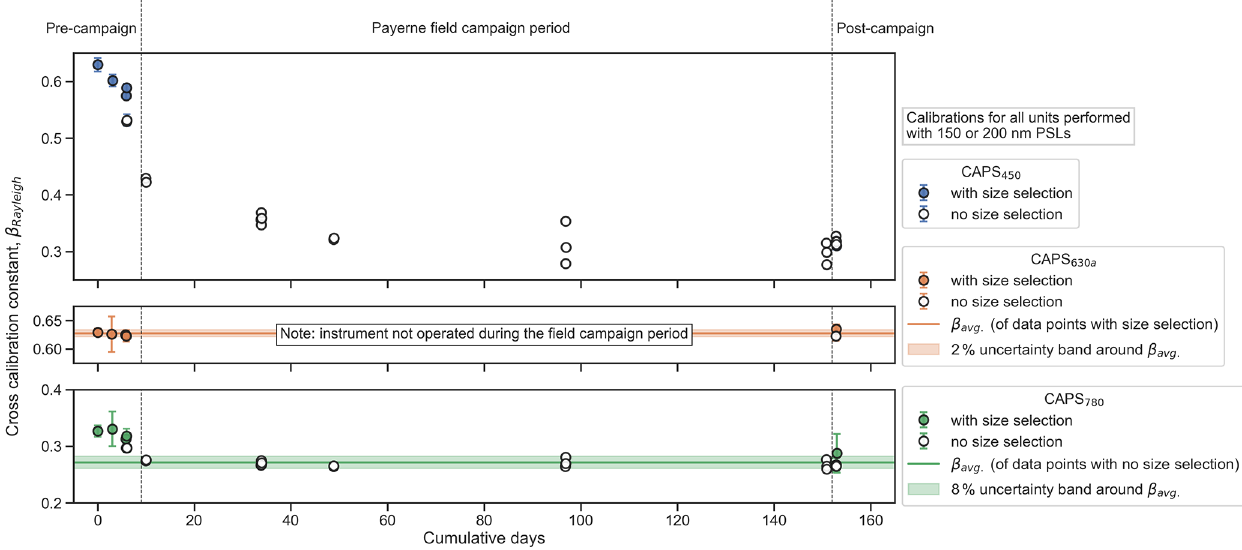
Figure 5. Rayleigh-regime cross-calibration constants ( β Rayleigh ) for three CAPS PMssa units (CAPS450, CAPS630a, CAPS780) measured before, during, and after the Payerne field campaign. Error bars indicate the standard deviation of the measured ratios used to determine each β Rayleigh value (see Sect.